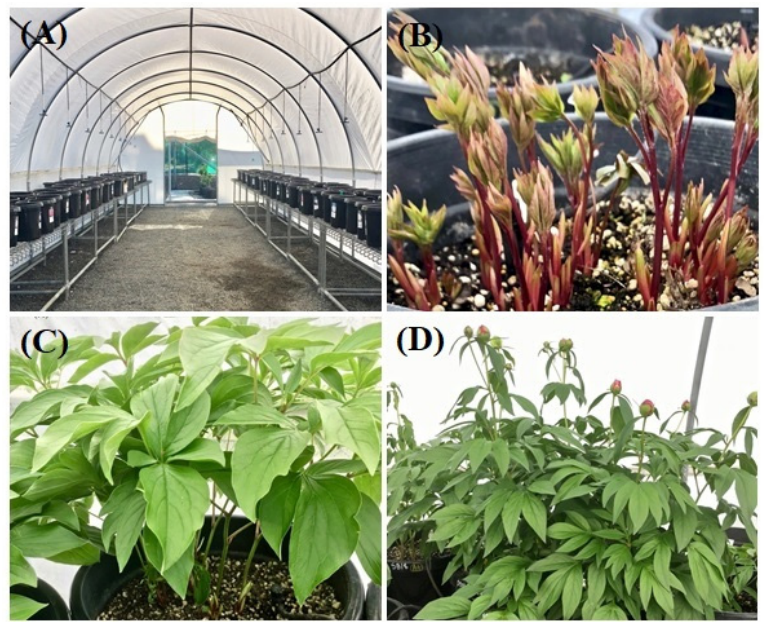
2018. The plants were then returned to the tunnel house and treated with 250 mL of 100 Figure 1. Peony plants ( A ) in a polyethylene tunnel house, ( B ) with emerging shoots, ( C ) with elongated stems, and ( D ) with fully-elongated leaves and flower buds. mg/L GA 3 on 28 June 2018.